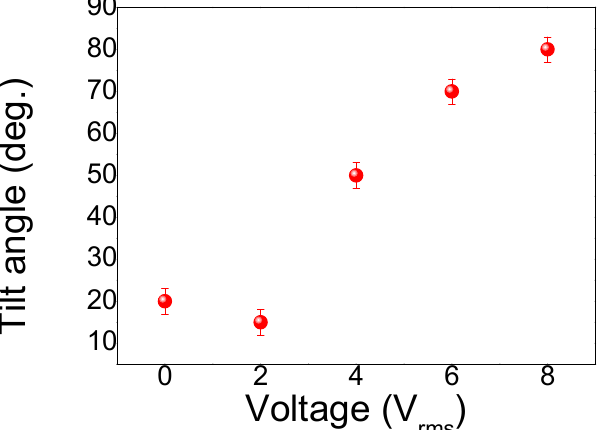
Figure 6. Variation of the tilting angle of the liquid crystal (LC) / gold nanoisland film (Au NIF) with various applied voltages.